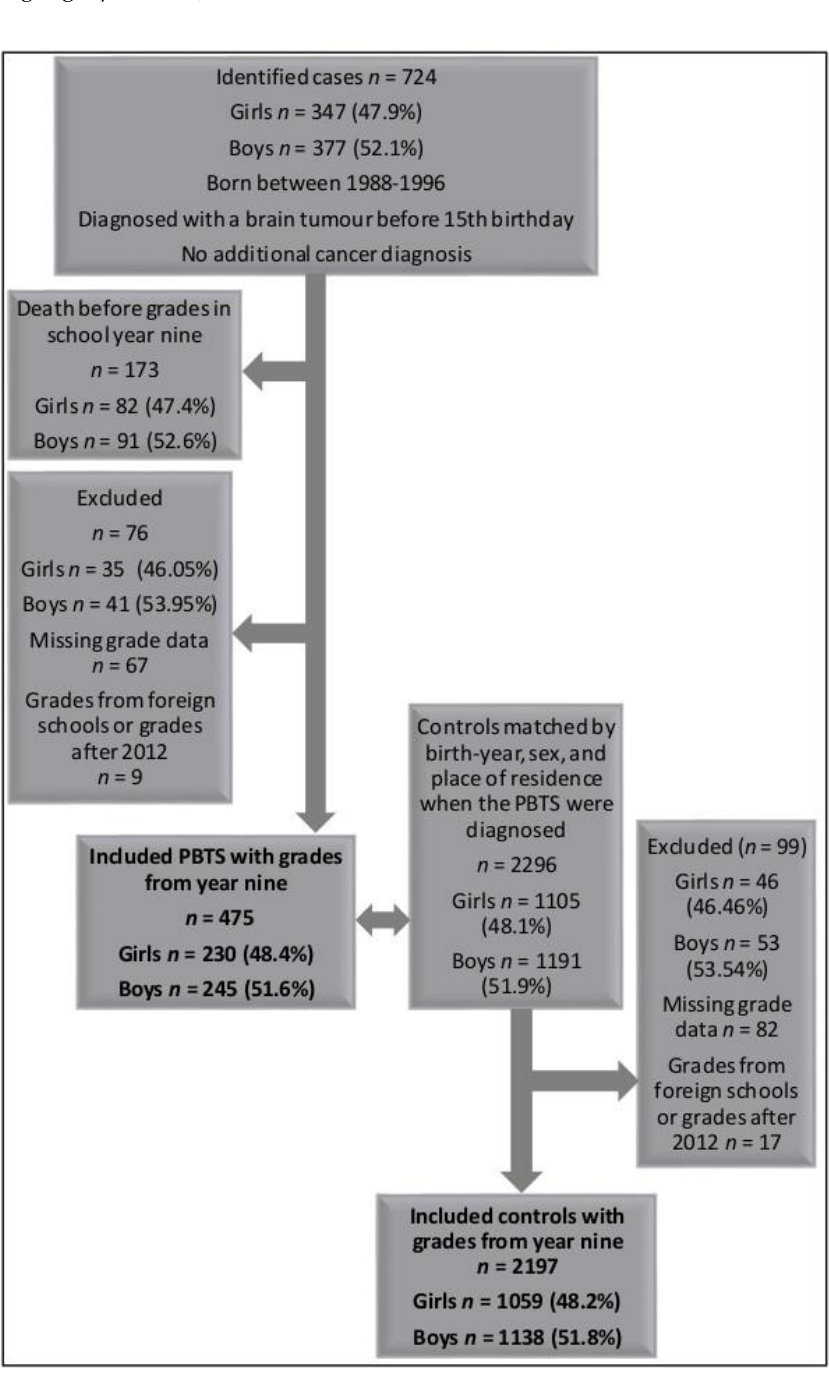
Figure 1. Inclusion and exclusion criteria of the paediatric brain tumour survivors (PBTS) and con-